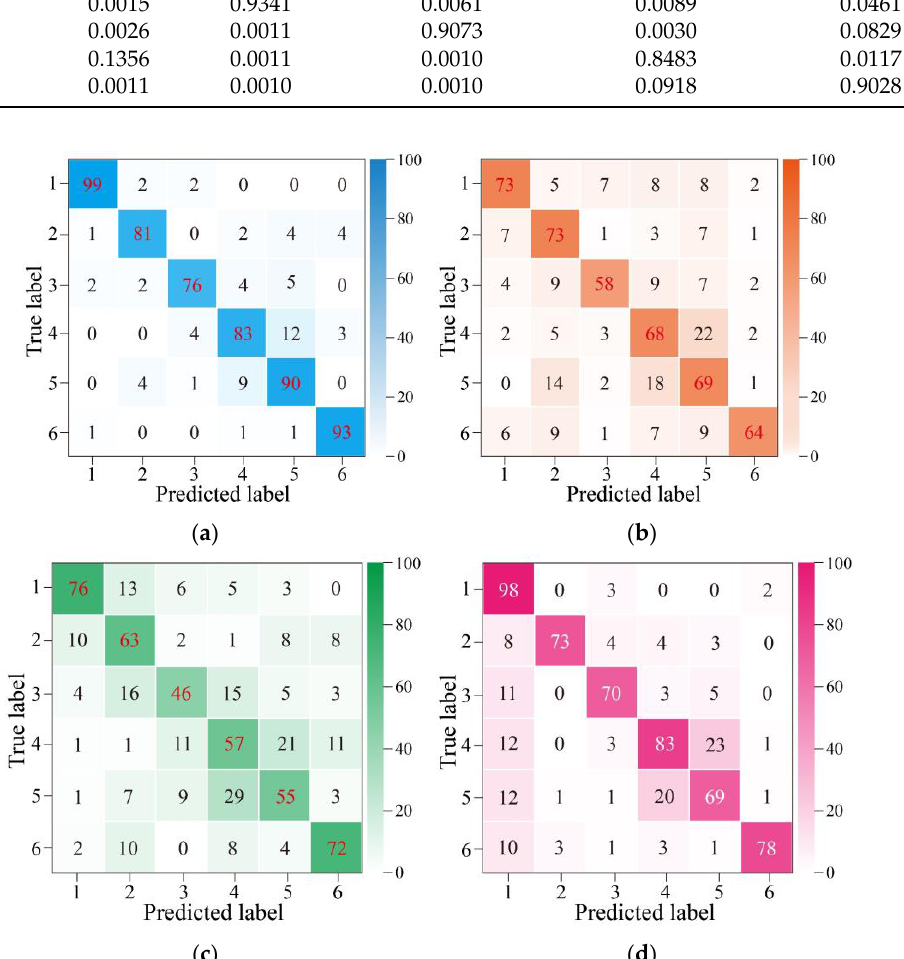
Figure 15. Confusion matrixes of each identification model on the test set, the meaning of digits: 1-wackestone, 2-granite, 3-schist, 4-quartz sandstone, 5-conglomerate, 6-crystalline dolomite. ( a )